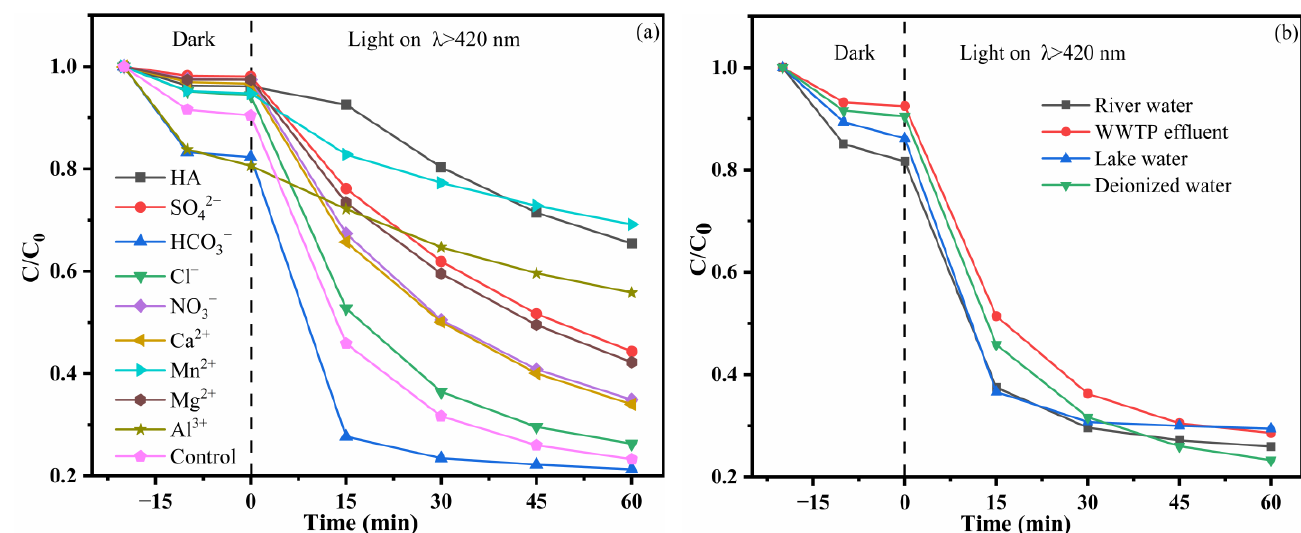
Figure 10. TC-HCl degradation catalyzed by 30% PCNS/BWO ( a ) with humic acid (10 mg/L) and different anions and cations (5 mM), and ( b ) with different water sources (20 mg/L).